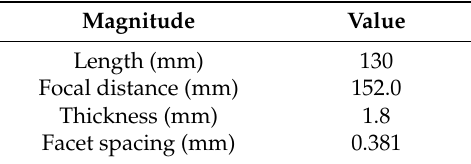
Table 1. Description of the Fresnel lens (POE).